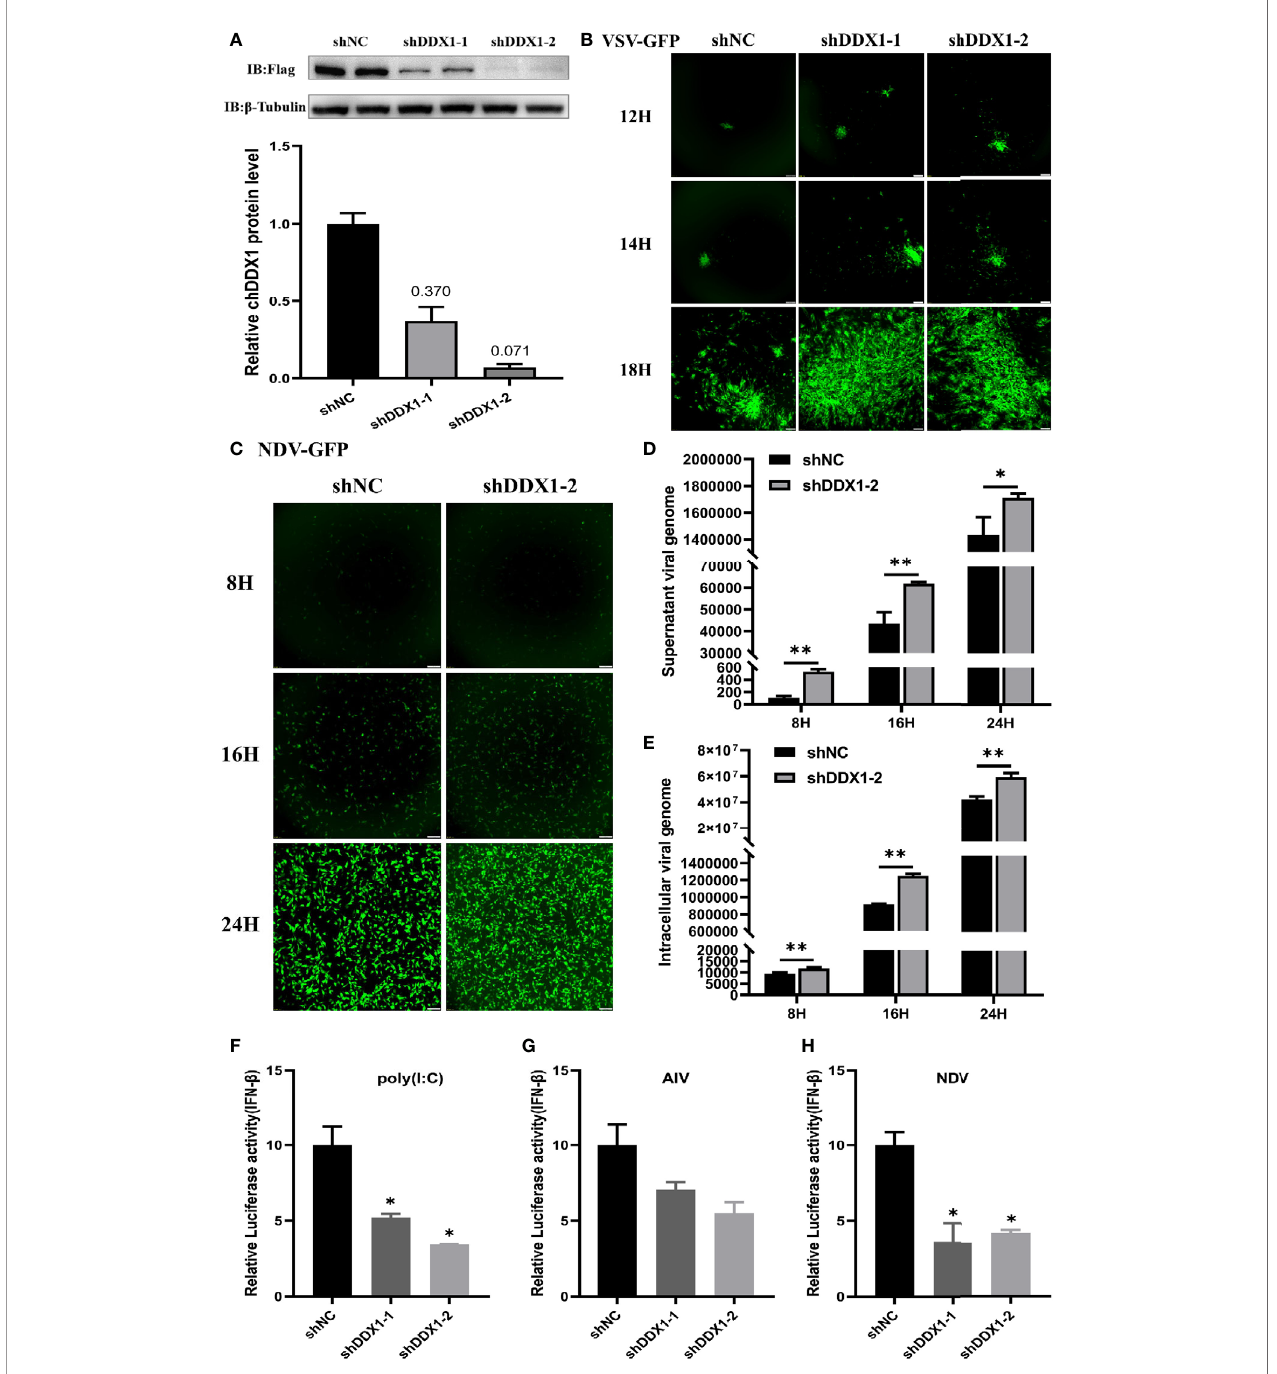
FIGURE 6 | chDDX1 knockdown decreased IFN- b production and increased viral yield. (A) Protein levels of chDDX1 in DF-1 cells cotransfected with expressing plasmid p3×FLAG-14-chDDX1 and RNAi plasmids (shDDX1-1, shDDX1-2, or shNC). Expression levels of FLAG-tagged chDDX1 were quanti fi ed using western blotting, and immunodetection was measured using anti-FLAG Ab. (B) Virus fl uorescence in DF-1 cells transfected with RNAi plasmids of chDDX1 and infected with VSV-GFP (MOI = 0.1). (C) Virus fl uorescence in DF-1 cells transfected with shDDX1-2 and infected with NDV-GFP (MOI = 0.1). (D) NSD14 NDV virus genome detected by qRT-PCR in the supernatant of chDDX1 knockdown (shDDX1-2) DF1 cells at 8, 16 and 24 hours after infection (MOI, 0.1 for 8, 16 and 24 hours). (E) – NSD14 NDV virus genome detected by qRT-PCR in chDDX1 knockdown DF1 cells (MOI, 0.1 for 8, 16 and 24 hours). (F) Luciferase assays for DF-1 cells cotransfected with RNAi plasmids (shDDX1-1, shDDX1-2, or shNC) and chIFN- b luciferase reporter plasmids and then stimulated with poly(I:C). (G, H) Luciferase reporter assays for DF-1 cells cotransfected with RNAi plasmids of chDDX1 (shDDX1-1, shDDX1-2, or shNC) and chIFN- b luciferase reporter plasmids and then infected with AIV or NDV. The difference between the experimental and control groups was * p < 0.05 or ** p <